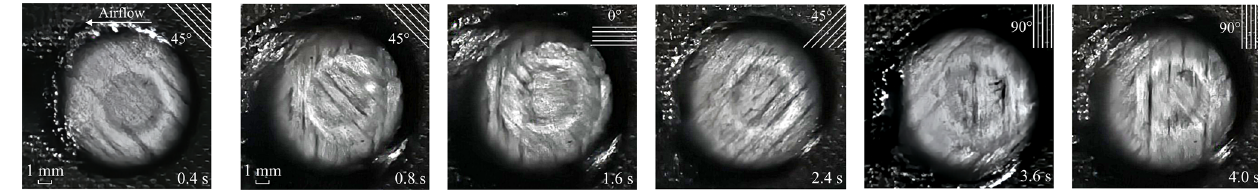
Figure 5. The instantaneous ablation morphology of laser irradiation surface.